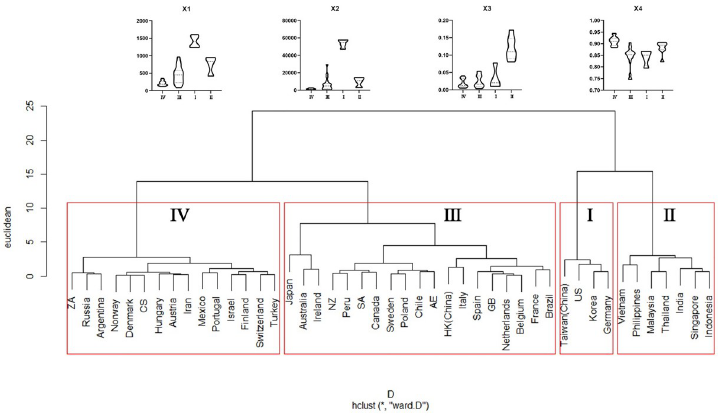
Fig 4. Cluster dendrogram of the main countries (regions) from which pests are intercepted on WPM in China. X1 = the total species of intercepted pests. X2 = the total number of intercepted pests. X3 = the interception rate of quarantine pests (quarantine pests intercepted/X2). X4 = the interception rate of insects and nematodes (insects and nematodes intercepted/X2). US = United States, ZA = South Africa, CS = Czech Republic, HK = Hong Kong, GB = United Kingdom, NZ = New Zealand, SA = Saudi Arabia, AE = United Emirates.